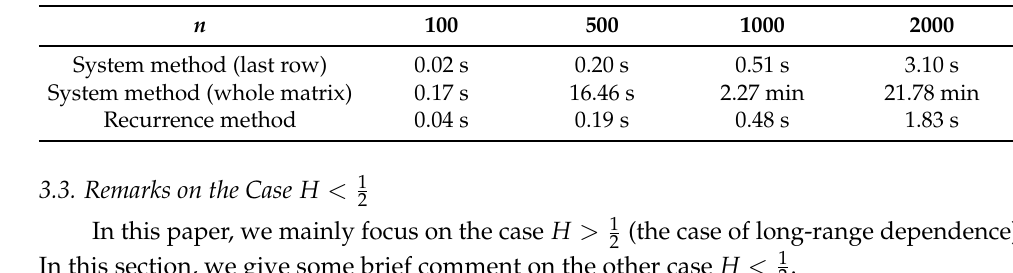
Table 7. Computation